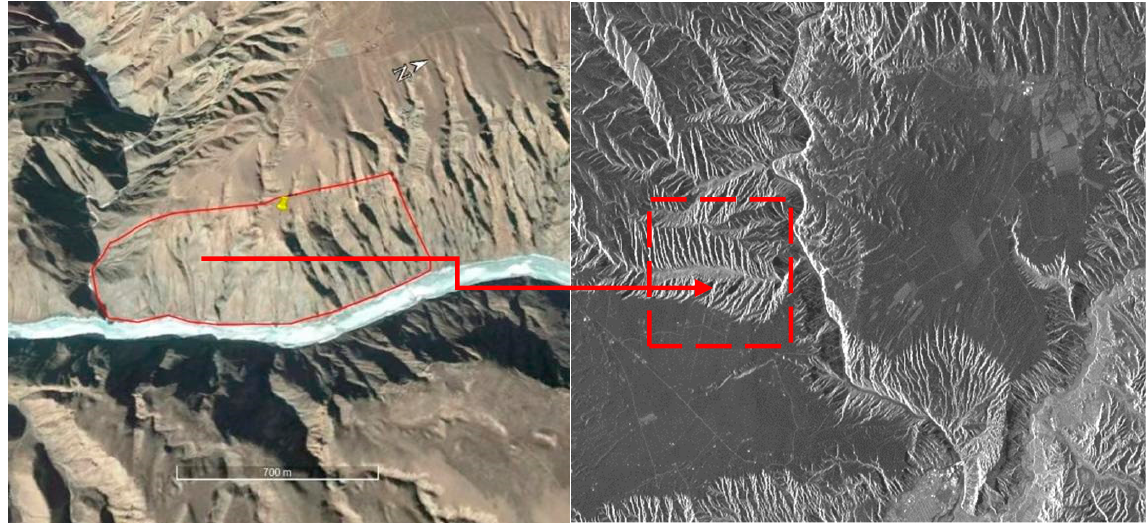
Figure 10. Remote sensing image of the slope. According to the monitoring results of the slope, we selected nine reference points in Figure 12 (1–9) to examine the deformation. The deformation statistic results of the corresponding points are shown in Figure